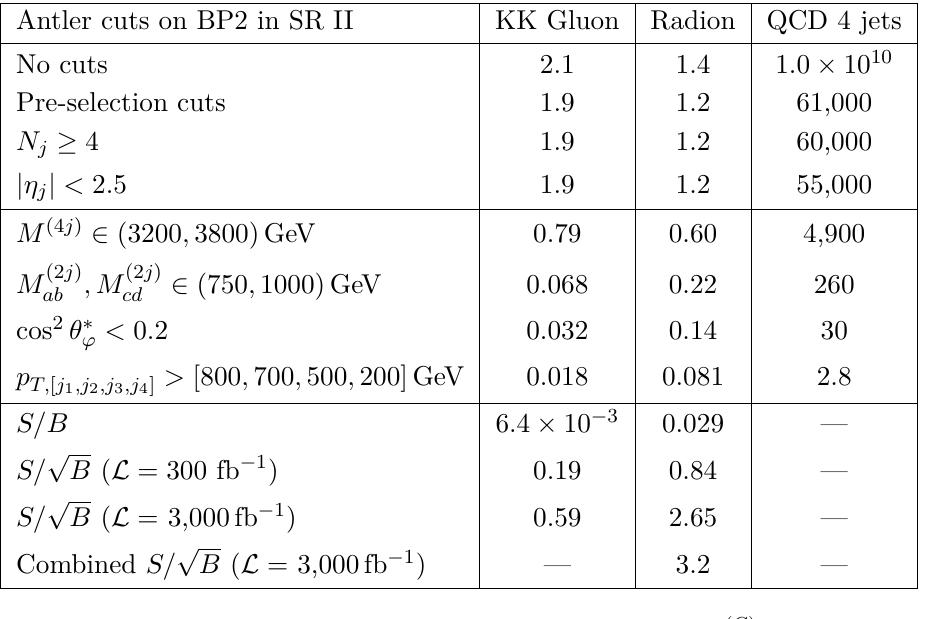
Table 7 . Cut flows of BP2 in SR II ( g grav = 6 , g g 3 TeV , and m ϕ = 1 TeV , see also table 1) and QCD 4-jet backgrounds, with a set of antler cuts. The same explanations including the pre-selection cuts as in the caption of table 4 are